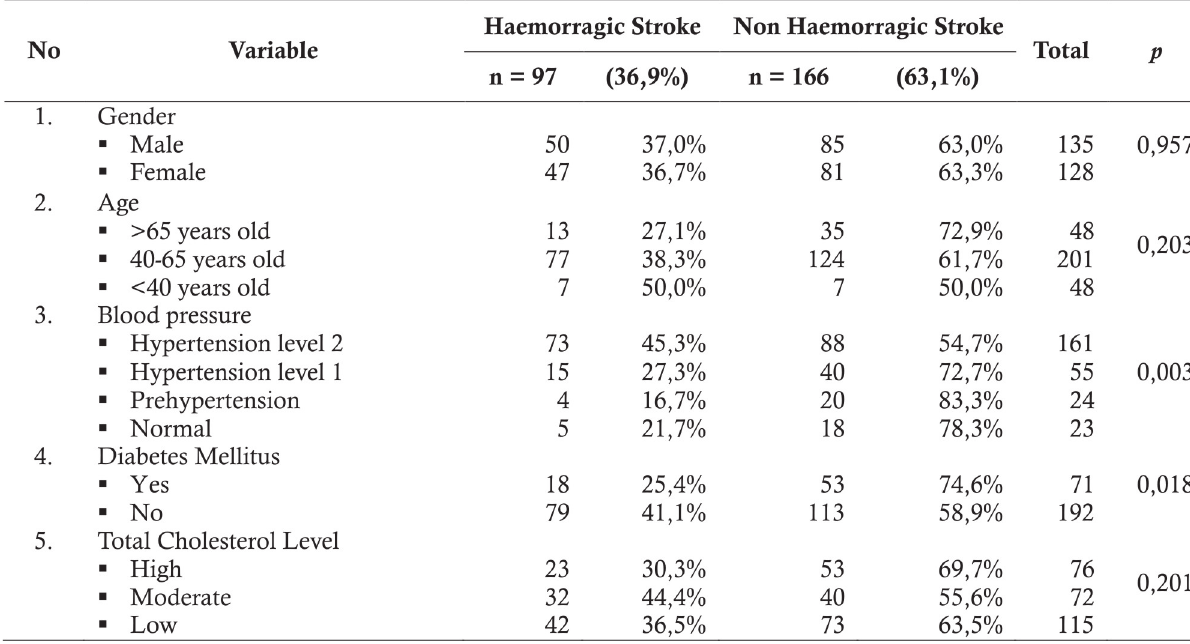
Table . Descriptive and Chi Square test for independent variables towards